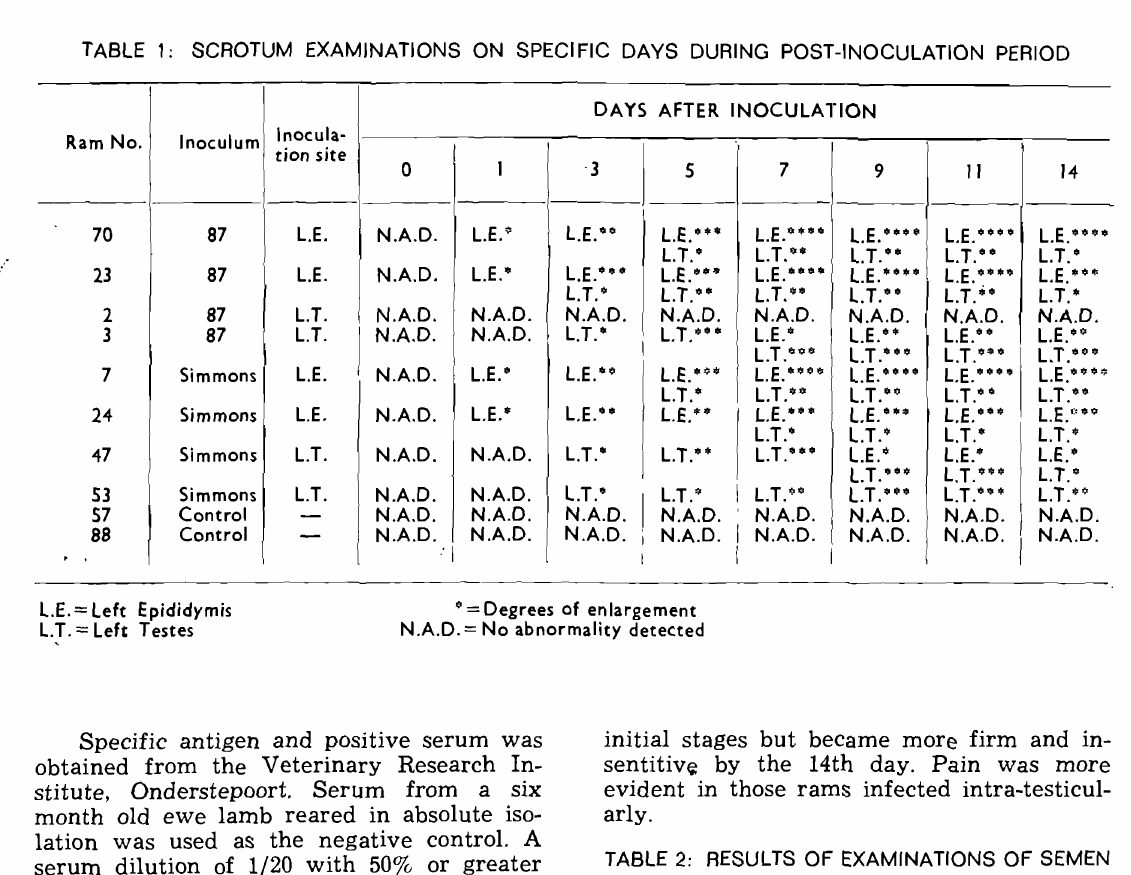
TABLE 2: RESULTS OF EXAMINATIONS OF SEMEN SMEARS STAINED WITH THE